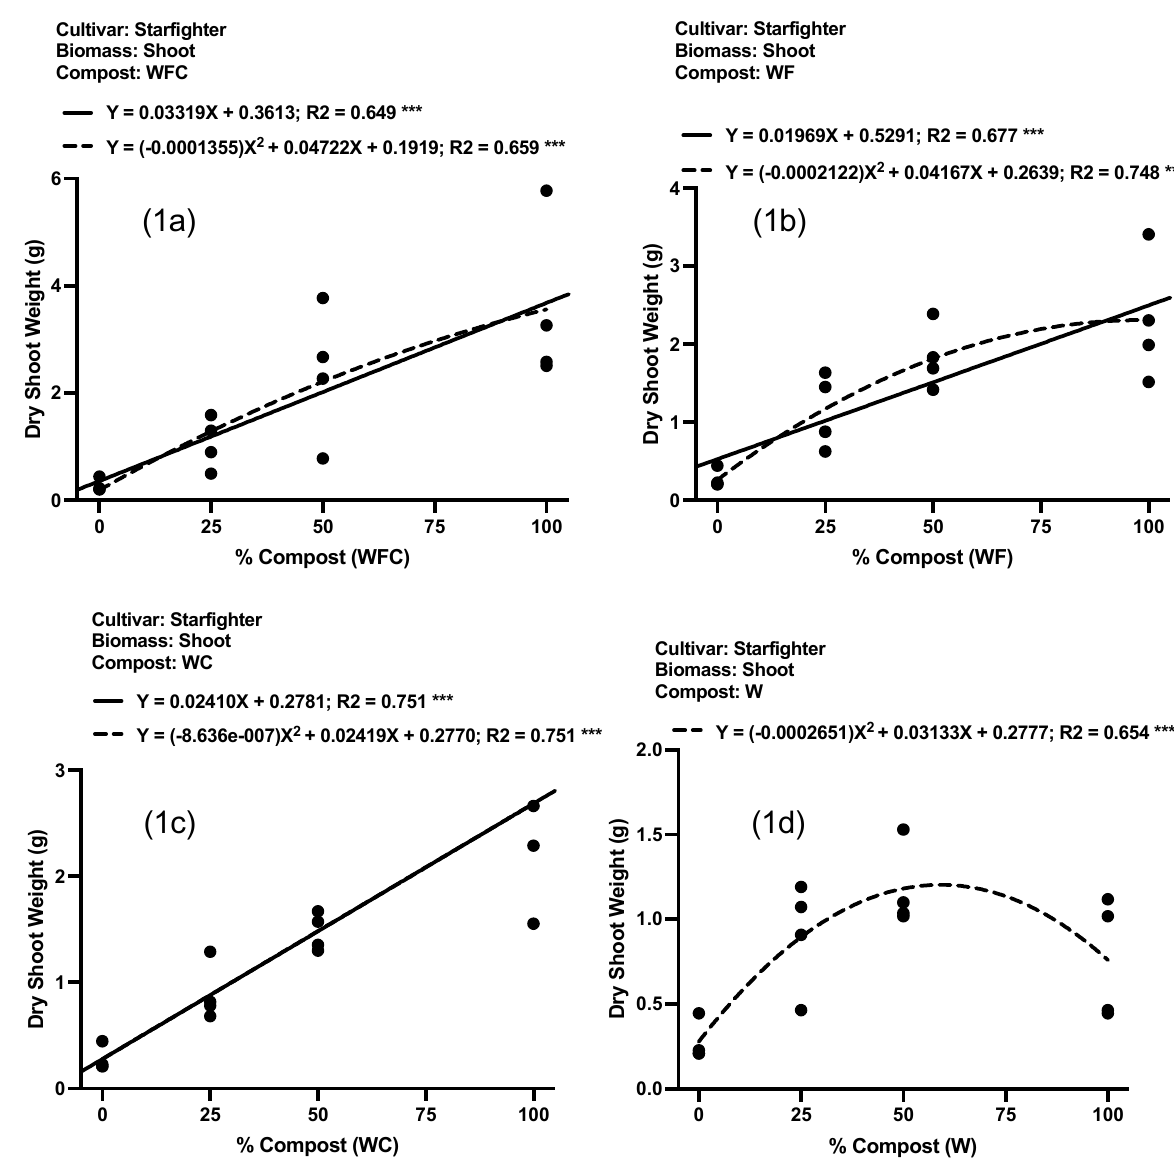
Figure 1. Effect of the percent of compost in growing media on the dry shoot biomass of cv. Starfighter: ( 1a ) Compost WFC; ( 1b ) Compost WF; ( 1c ) Compost WC; and ( 1d ) Compost W. *** significant at p <